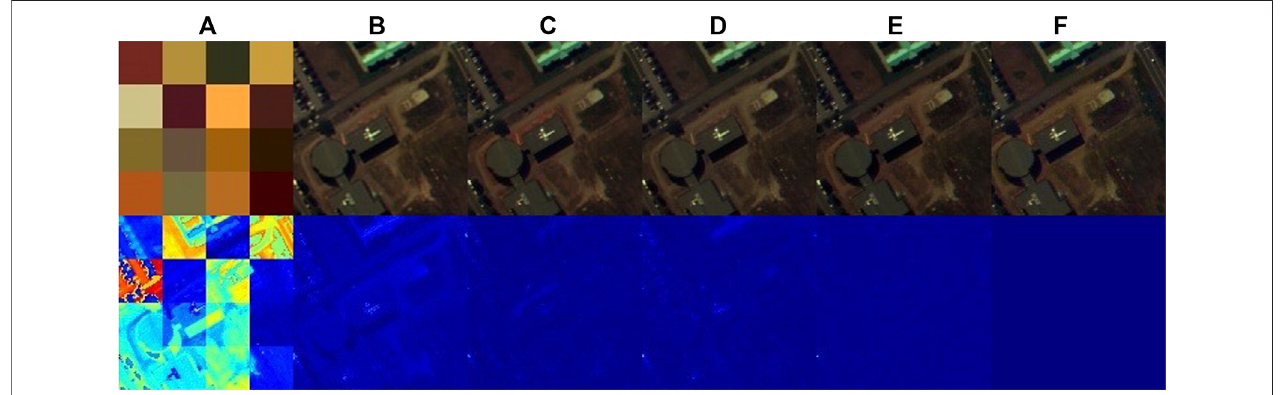
FIGURE5| QualitativecomparisononPaviaUniversitydatasetincaseof32×spatialdownsamplingandType2spectraldownsampling.Forvisualizationpurposes three spectral bands (66-28-0) are selected from the output data and difference images are calculated based on that preselected three bands. The fi rst row shows (A)